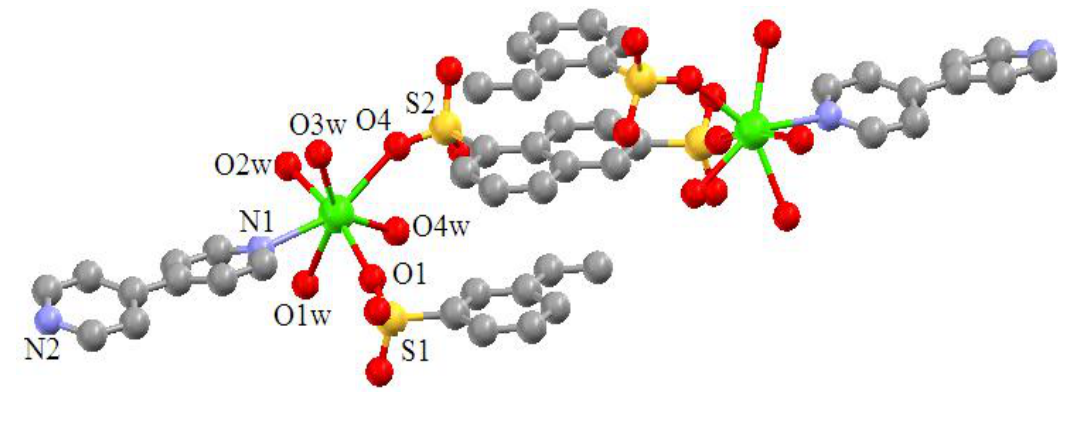
Figure 2. 1D chained helical structure of the Ca(II) coordination polymer. The uncoordinated O atoms and the O atoms from coordinated water molecules were omitted for